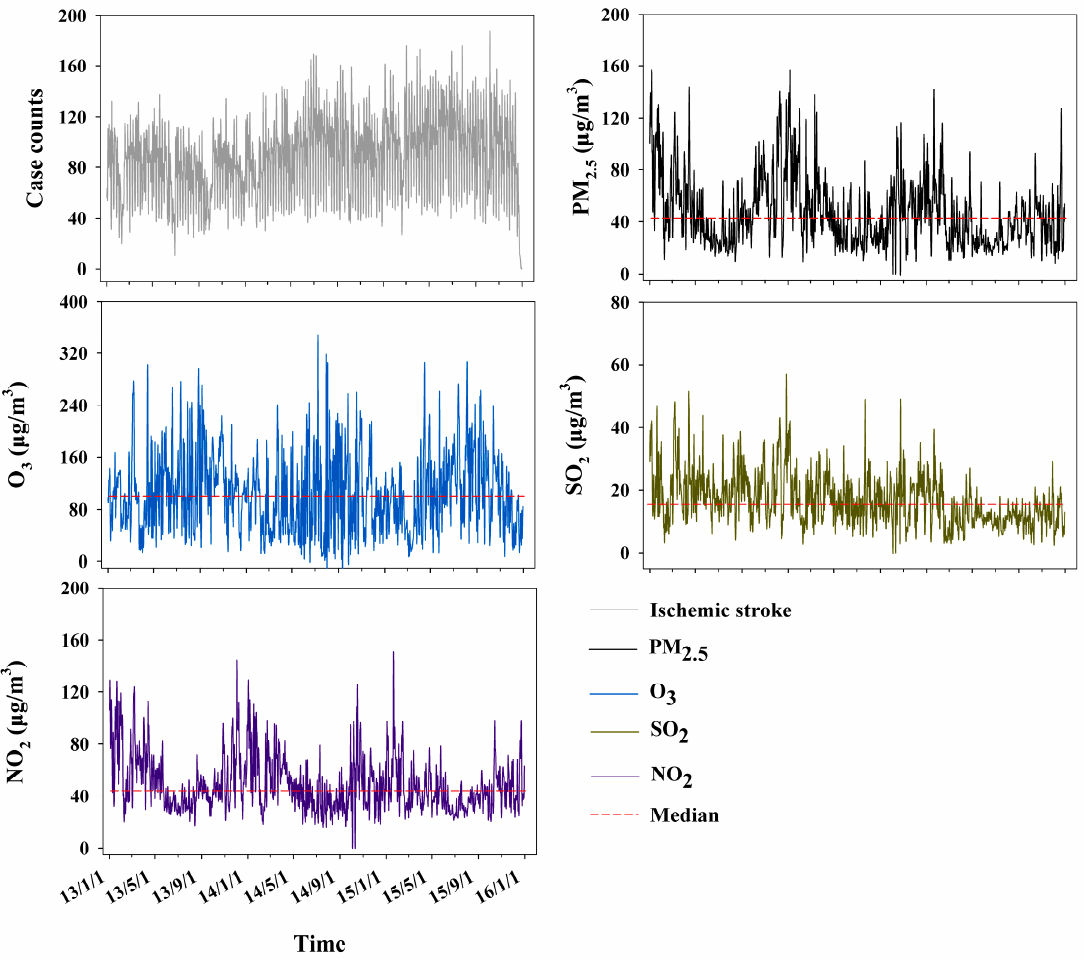
Figure 2. Daily number of ischemic stroke cases, and daily values of air pollutants including PM 2.5 , O 3 , SO 2 , and NO 2 over the study time period of 2013–2015.